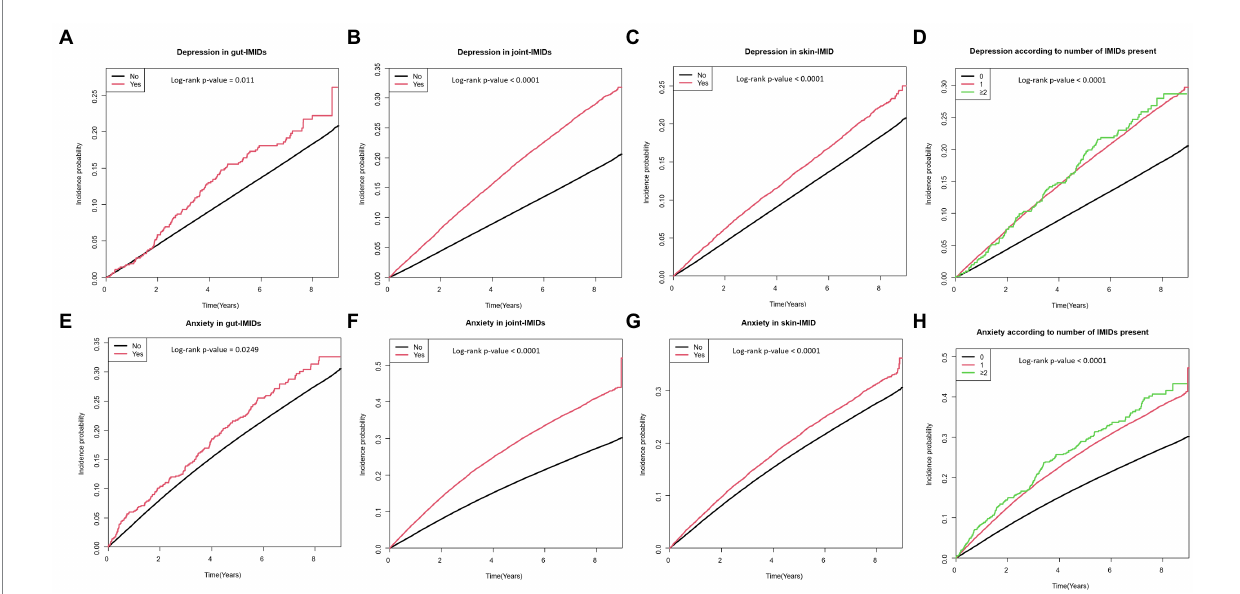
FIGURE 2 Cumulative incidence of depression in patients with (A) gut IMIDs, (B) joint IMIDs, (C) skin IMID, and (D) different numbers of IMIDs (0, 1, and ≥ 2); and cumulative incidence of anxiety in patients with (E) gut IMIDs, (F) joint IMIDs, (G) skin IMID, and (H) different numbers of IMIDs (0, 1, and ≥ 2). IMIDs, immune-mediated inflammatory disease.